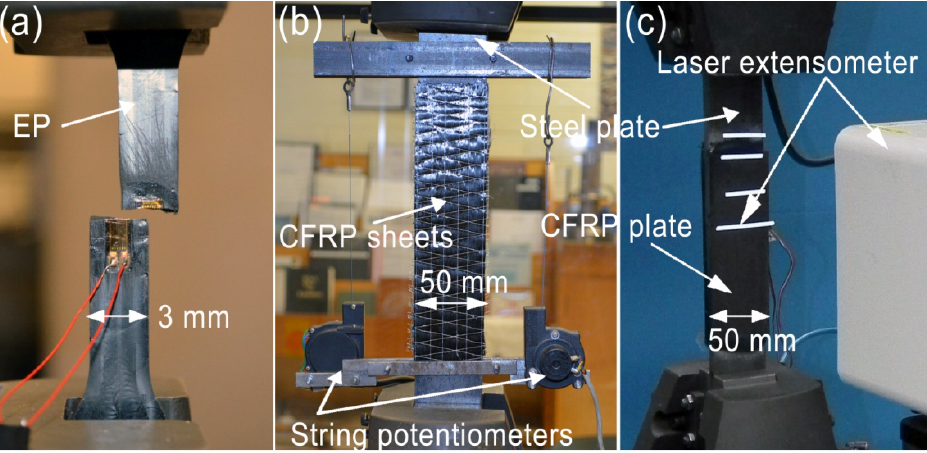
Figure 2. Experimental setup and instrumentation for ( a ) EP specimens; ( b ) DJS specimens; and ( c ) DJL